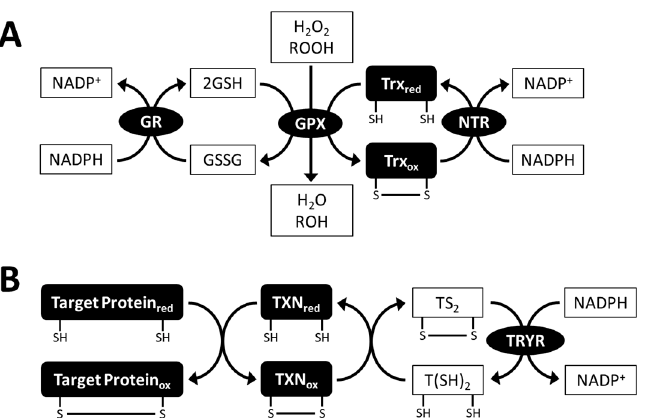
Figure 5. Glutathione peroxidase (GPX) reaction ( A ) and trypanothione (T(SH) 2 ) system ( B ). GPX uses glutathione (GSH) or thioredoxin (Trx) as electron donors. T(SH) 2 system is biochemically and physiologically characterized in trypanosomatids, and Euglena gracilis contains a set of genes encoding the components of the T(SH) 2 system. GSSG, oxidized glutathione; GR, glutathione reductase; NTR, NADPH-dependent thioredoxin reductase; TS 2 , oxidized trypanothione; TRYR, trypanothione reductase; TXN, tryparedoxin; red, reduced form; ox, oxidized form.